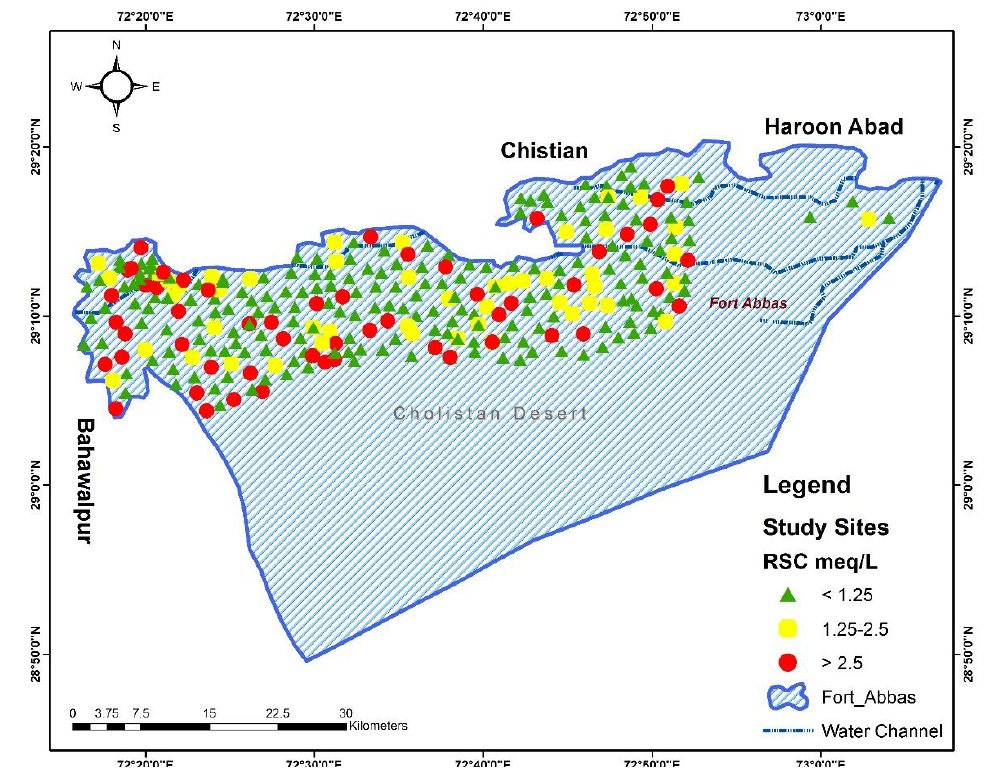
Figure 4. Status of residual sodium carbonate (RSC) of groundwater in Tehsil Fort Abbas.